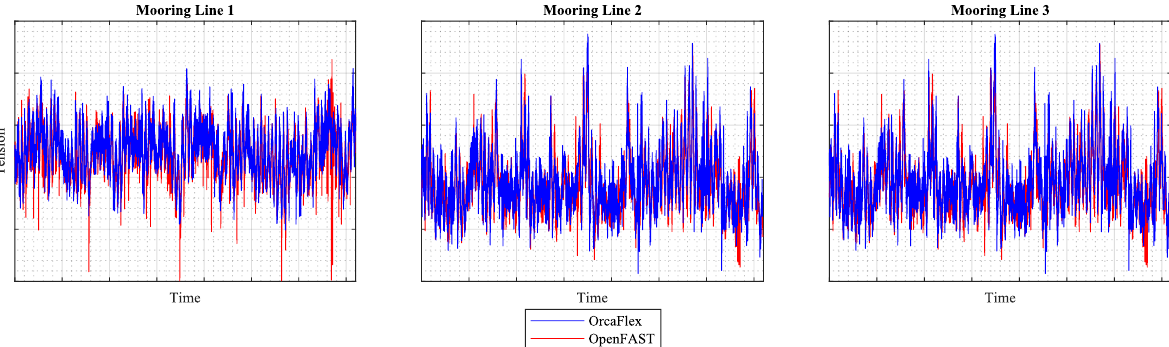
Figure 14. Comparison of mooring line tension. Note that the irregular sea states are different realizations of the same wave